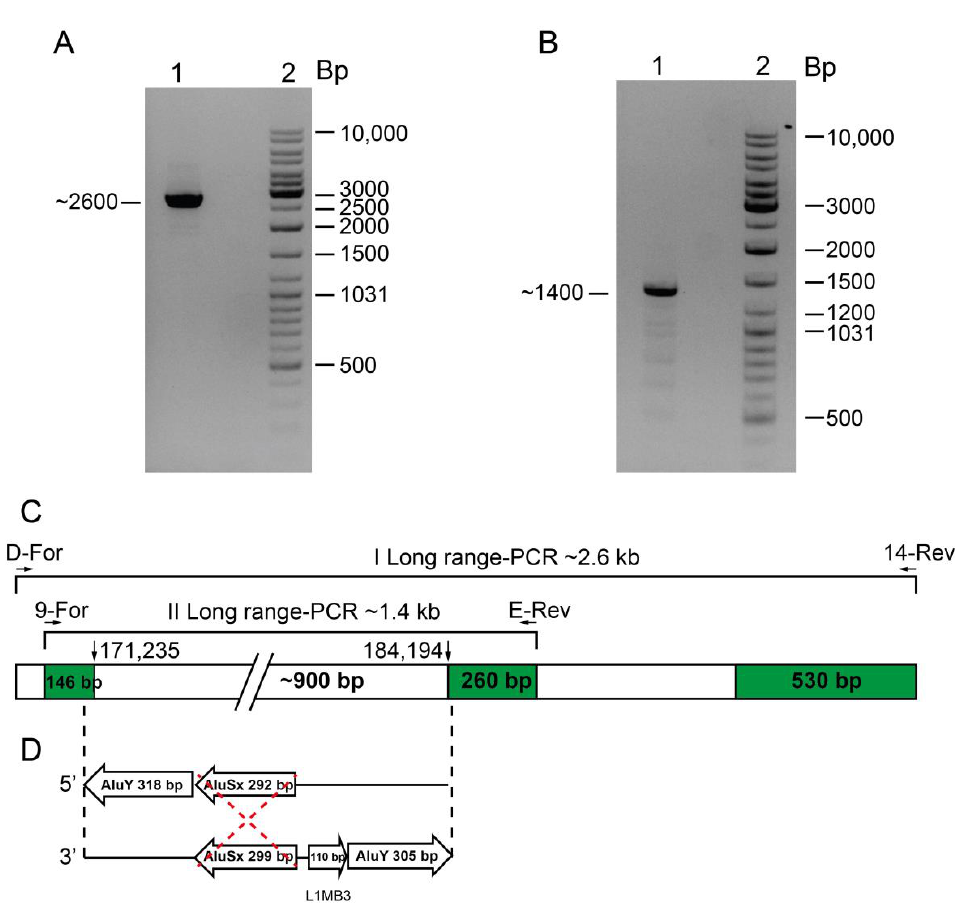
and normal control ( y -axis). The position of the different probes on the α -globin gene cluster is indicated on the x -axis. In red, the probes with half-dose; in gray, the probes with normal dosage. ( F – J ) Quantitative real-time PCR analysis of 33 probes (primers are reported in Table S2) posed in regions not tested by MLPA: red diamonds show fragments in half-dose; blue diamonds show normal dosage. The localization of the MLPA probes is indicated by the arrows. ( K , L ) Sequencing of the long-range gap-PCR fragments. In the middle has been reported the breakpoint of the deletion, above and below, respectively, the regions at 5 (cid:48) and 3 (cid:48) . The new deletions most likely originated from events of non-homologous recombination mediated by short sequences (highlighted with a box),